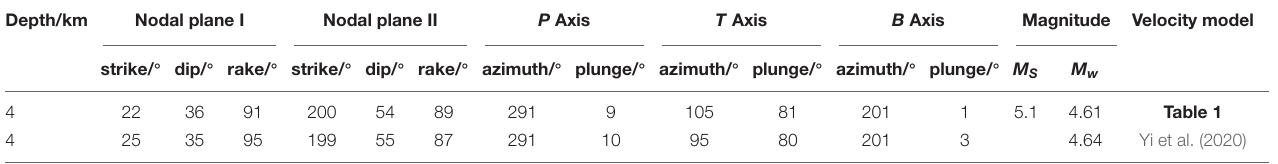
TABLE 2 | Focal mechanism solutions for the M S 5.1 Qingbaijiang earthquake from different velocity models. Depth/km Nodal plane I Nodal plane